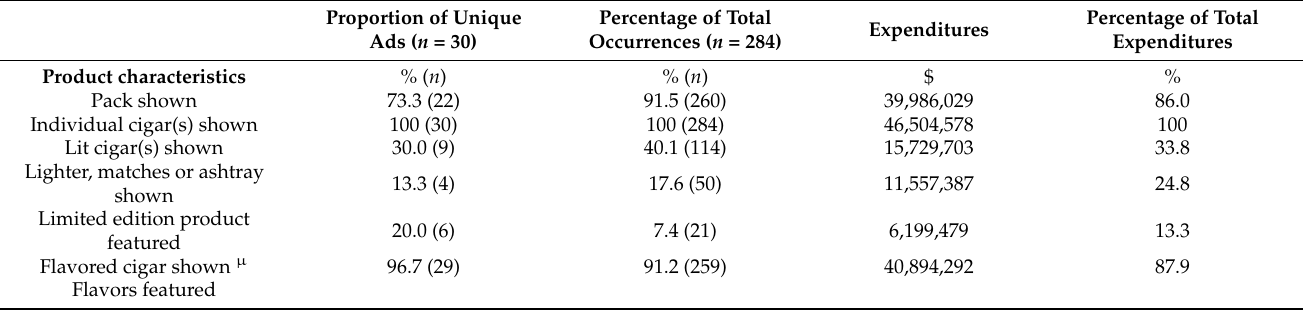
Table 1. Characteristics of Unique Ads, Ad Occurrences and Corresponding Expenditures for Black & Mild Print Magazine Ads,